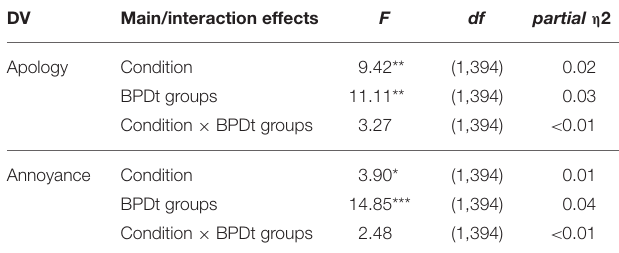
TABLE 3 | Descriptive statistics for comparison groups in experiment 2. Groups